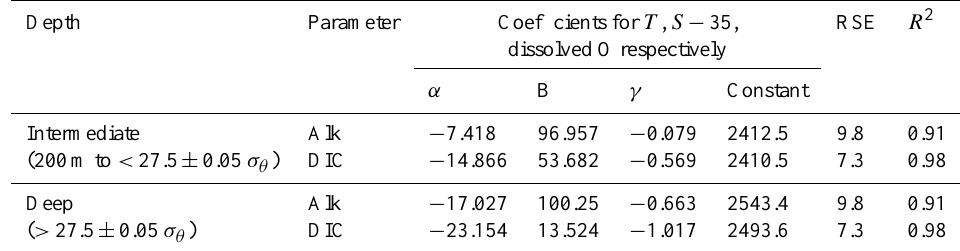
Table 3. Coefficients and constants, residual standard error and R 2 for the MLR algorithms; see equations in text.